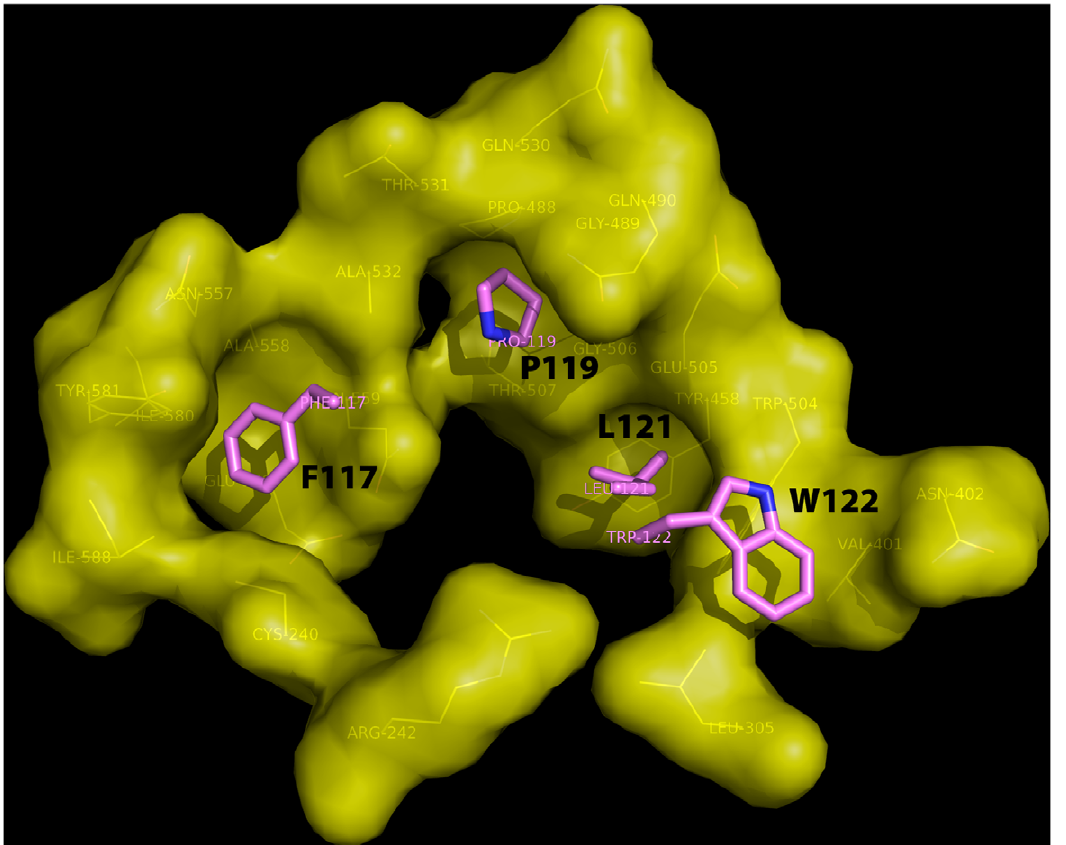
Figure 3. Four hydrophobic residues of the ephrin-B2 G-H loop insert in four hydrophobic HeV-G pockets. The four ephrin residues (F117, P119, L121 and W122) are illustrated as purple sticks. The HeV-G pockets are shown as a yellow surface. The residues defining these pockets are shown as yellow lines and are labeled.